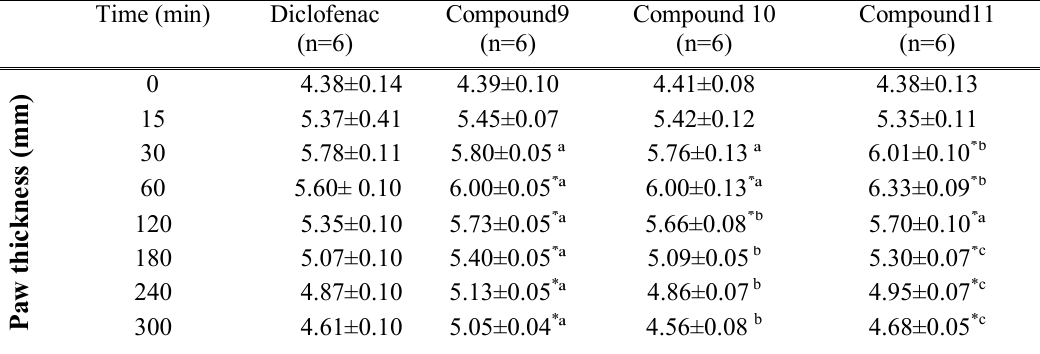
Table 3: Effect of Diclofenac and Compounds 9, 10 and 11 on egg-white induced paw edema in rats. Treatment